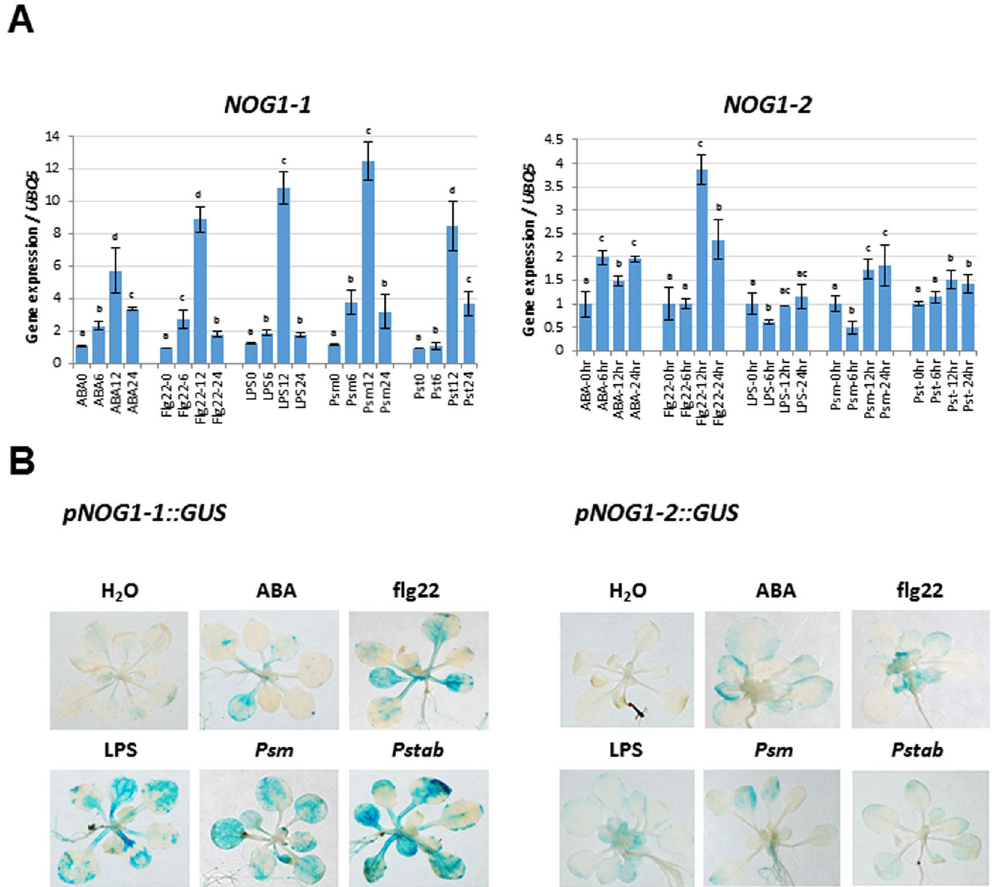
Figure 3. NOG1-1 and NOG1-2 are induced by ABA, PAMPs, host and nonhost bacterial pathogens. ( A ) Arabidopsis wild-type (Col-0) plants were individually syringe-infiltrated with ABA (10 µ M), Flg22 (20 µ M), or LPS (100ng), or flood-inoculated with the pathogens P. syringae pv. maculicola ( Psm ) and P. syringae pv. tabaci ( Pstab ) at 1 × 10 4 CFU/ml. RNA was isolated from tissue samples harvested at 0 hr, 6 hr, 12 hr and 24 hr, and qRT-PCR was performed. Bars indicate relative gene expression in comparison with the housekeeping gene Ubiquitin ( UBQ5 ) and in relation to 0 hr time that was considered as 1. Different letters above bars indicate a statistically significant difference within a treatment using two-way ANOVA ( P < 0.01). Error bars represent the standard deviation of three biological replicates (three technical replicates for each biological replicate). ( B ) β -Glucuronidase (GUS) staining of pNOG1-1::GUS and pNOG1-2::GUS in response to ABA, PAMPs, bacterial pathogens. pNOG1-1::GUS (left panel) and pNOG1-2::GUS (right panel) expression was measured 12 hr after treatment with ABA, flg22, LPS, Psm and Pstab . Seedlings were flood-inoculated with both pathogens (1.4 × 10 6 CFU/ml), ABA (10 µ M) and PMAPs (flg22: 20 µ M, and LPS: 100ng). After 2 hr of GUS straining, plants were washed with sterile water and images were